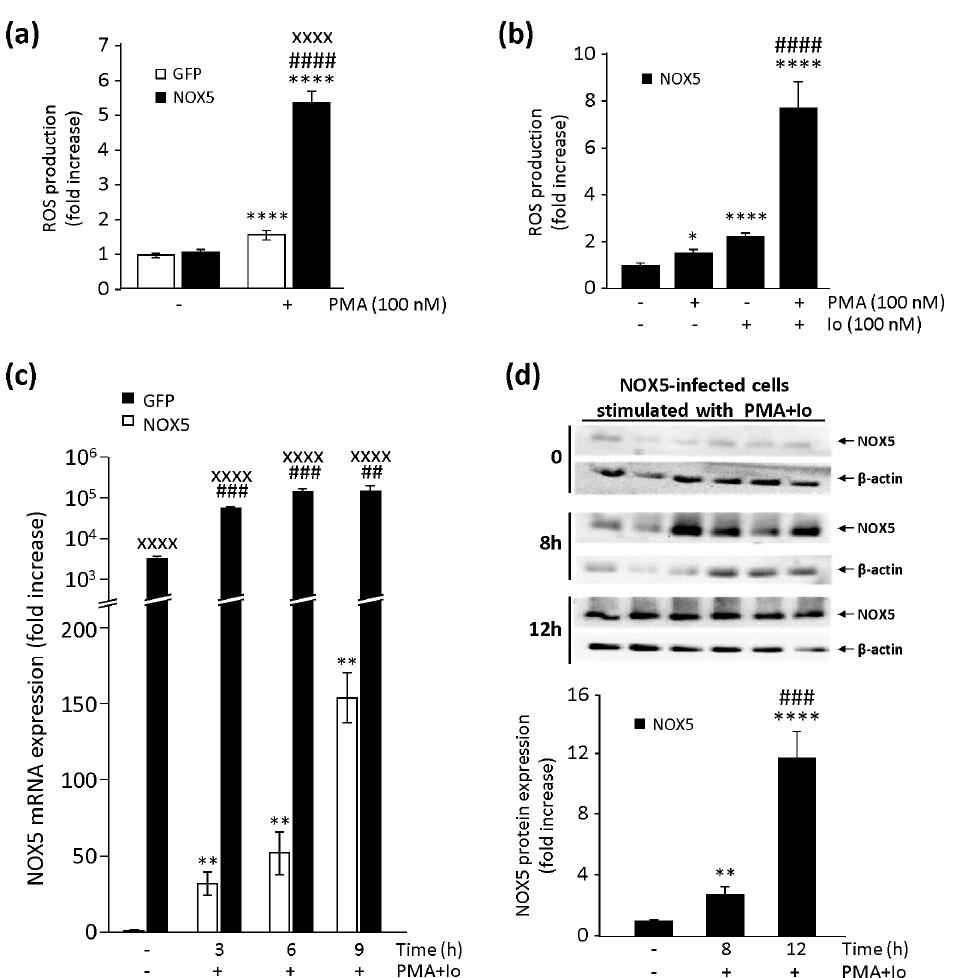
Figure 3. Characterization of NOX5 pharmacological stimuli in infected TeloHAEC. ( a ) ROS production measurements in NOX5- β - and GFP-infected cells for 24 h, and then stimulated with phorbol 12-myristate 13-acetate (PMA). n = 6. **** p < 0.0001 vs. non-stimulated GFP, #### p < 0.0001